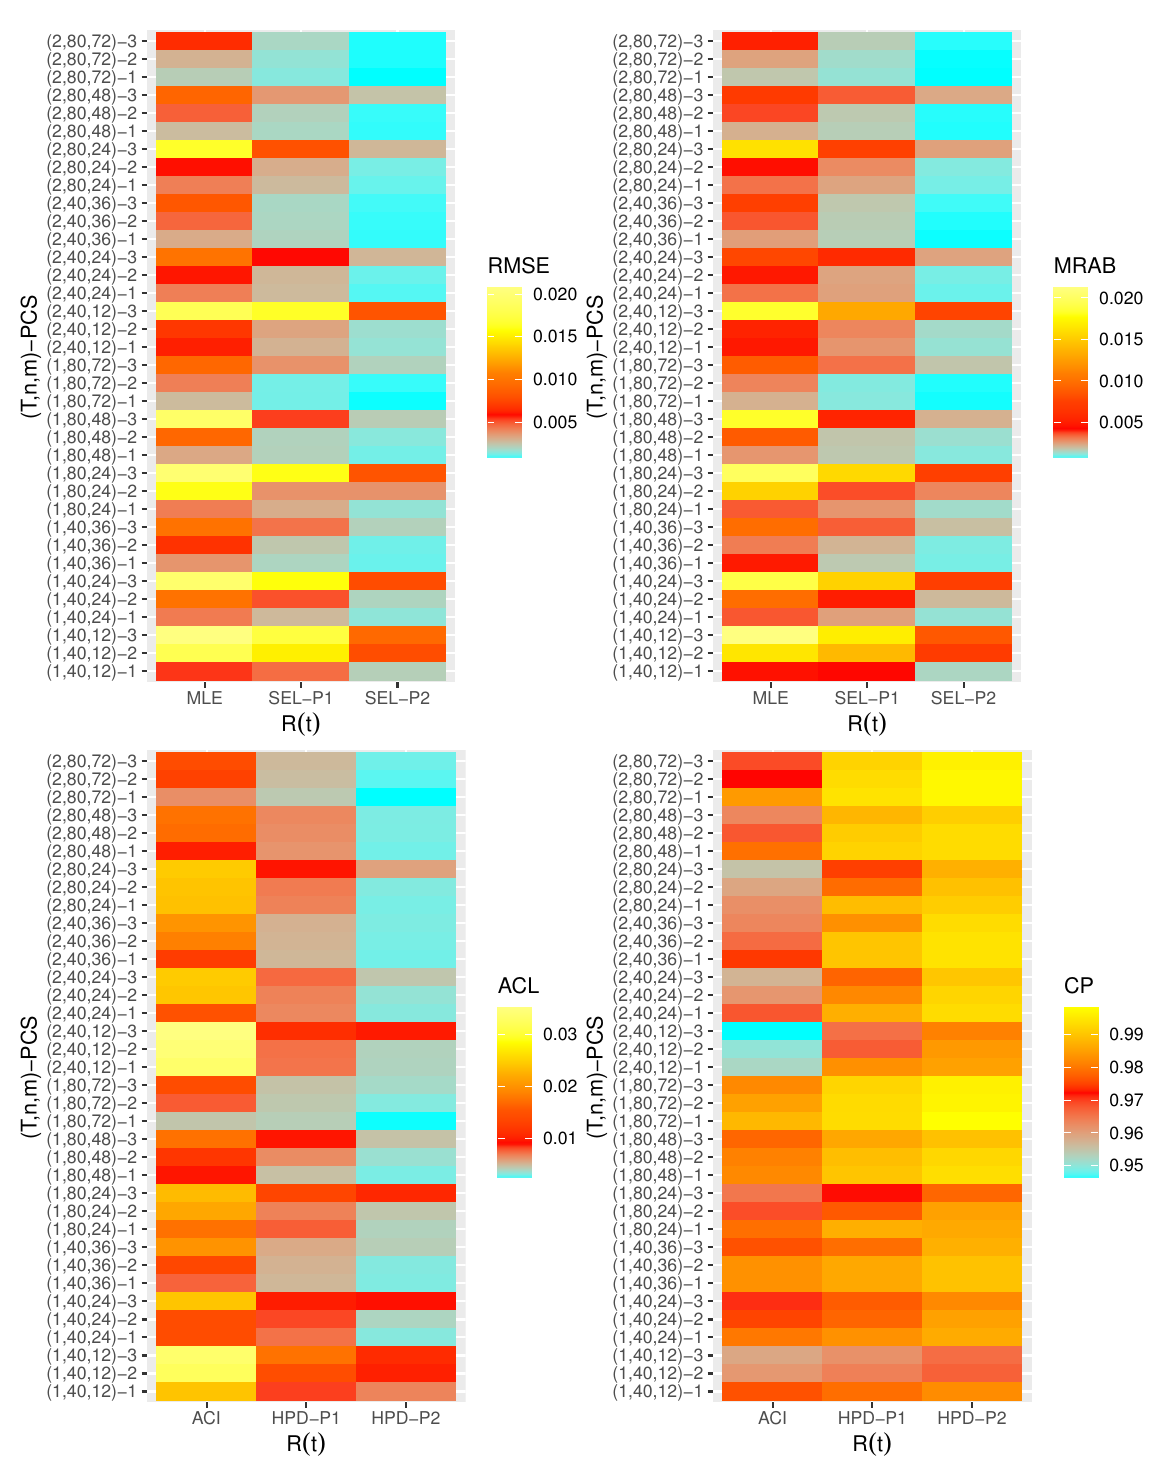
Figure 4. The heatmaps for the estimation results of R ( t ) when λ =